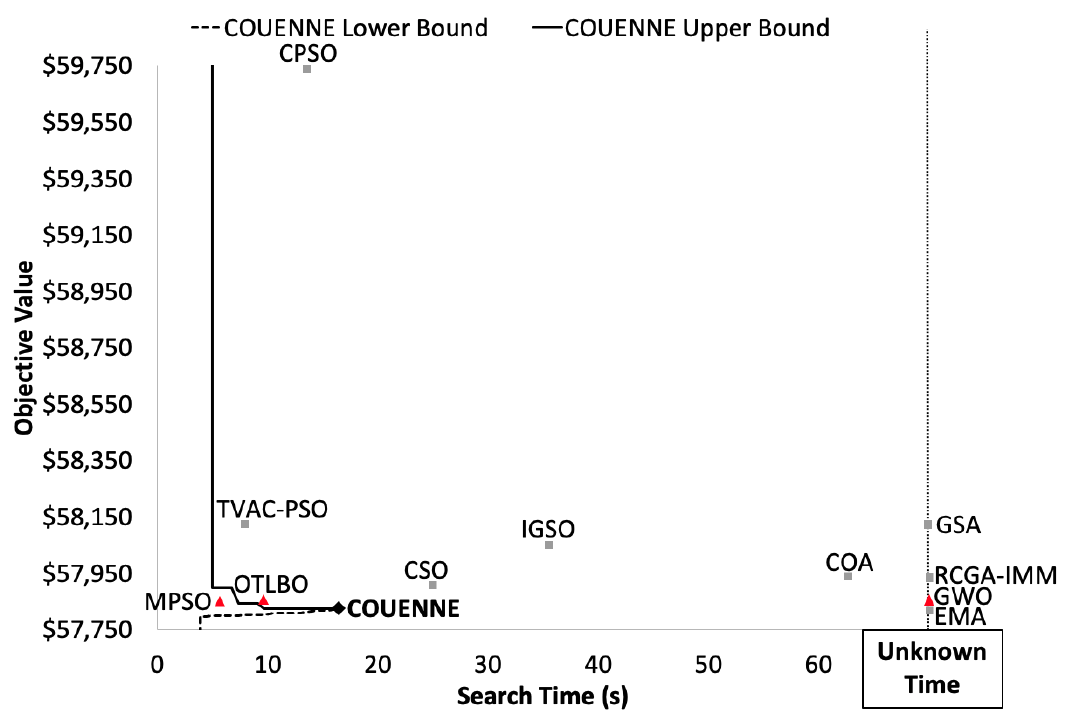
Figure 4. Search progression of COUENNE compared with optimal values obtained using metaheuristic search algorithms for test instance 4. Red triangles represent solutions which violate generating unit operating